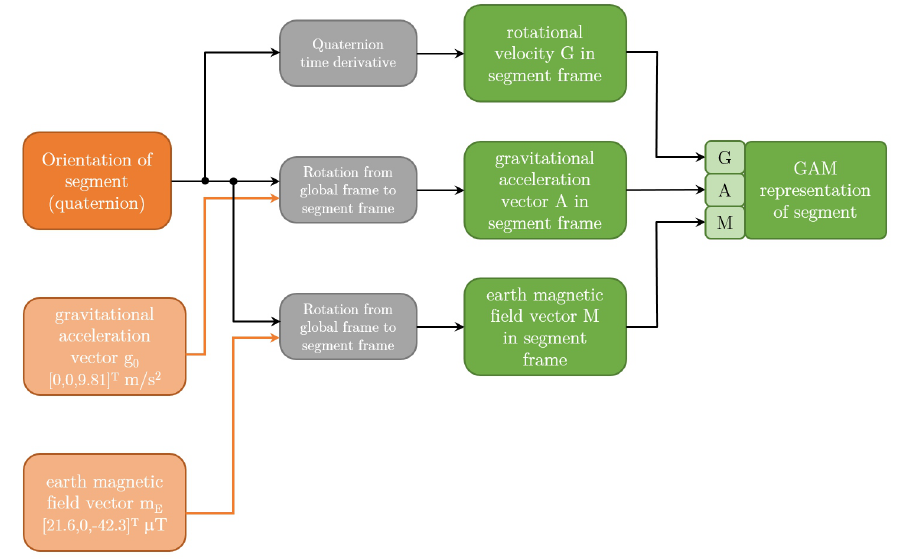
Figure 4. Figure shows the calculation of GAM representation from quaternion